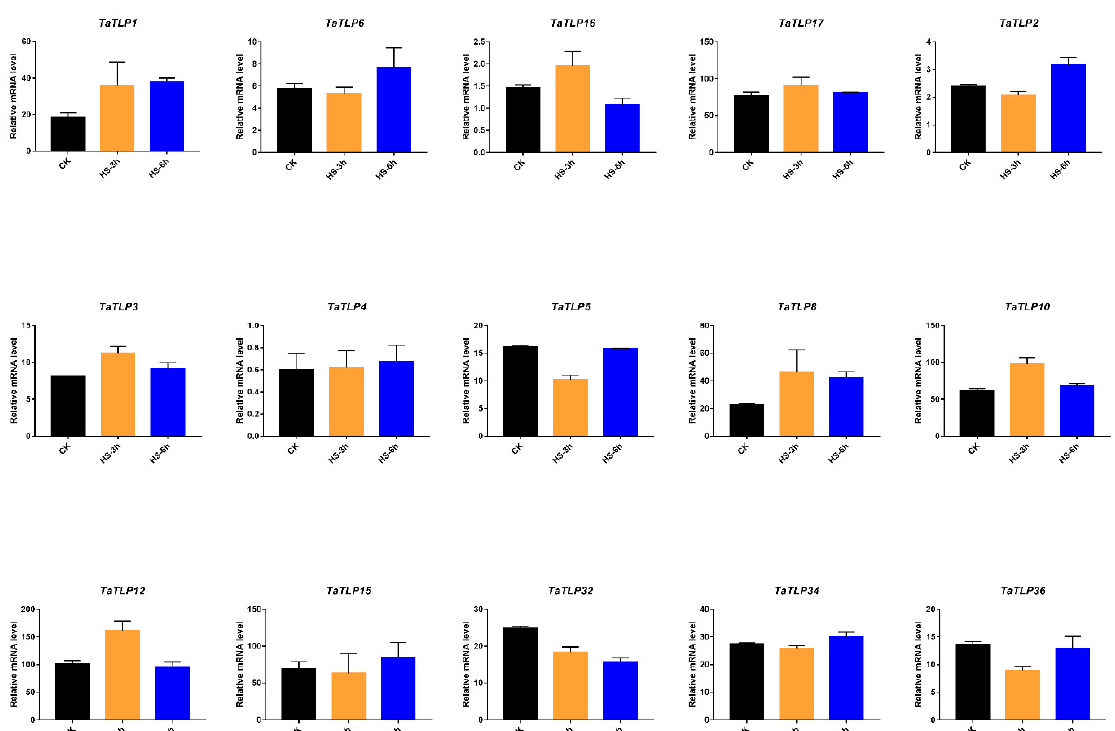
Figure 7. Expression analysis of TaTLP genes under high temperature at different time